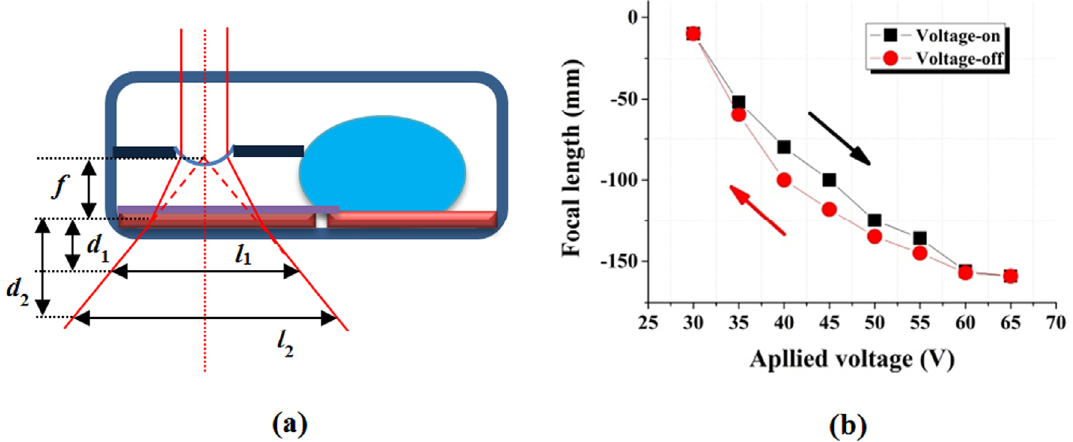
Figure 5. Protocol adopted for the determination of focal length ( a ) and focal length versus applied voltage ( b